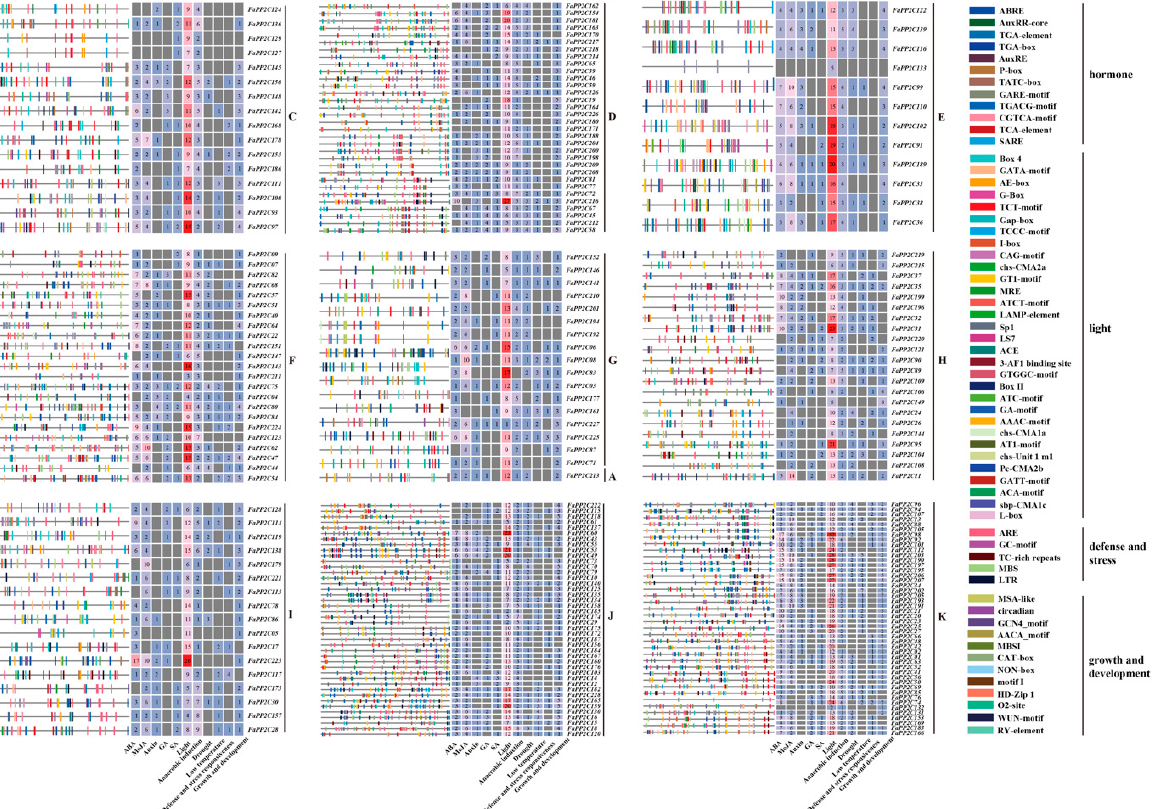
Figure 8. Cis -regulatory element analysis of the FaPP2C genes. Note: Based on different subfamilies (C–K), the analysis of cis -elements was carried out. Different colors on the right represent different elements. All elements can be divided into four categories, namely, hormone response elements, light response elements, defense and stress response elements, and growth and development related elements. The total number of hormone response elements (ABA, MeJA, auxin, JA, SA), light response elements, anaerobic induction elements, drought response elements, low temperature response elements, defense and stress response elements, and growth and development response elements are shown in the heat map.